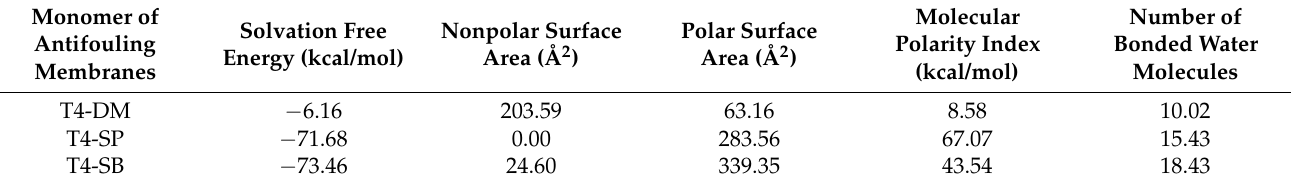
Table 3. Properties of monomer of three antifouling